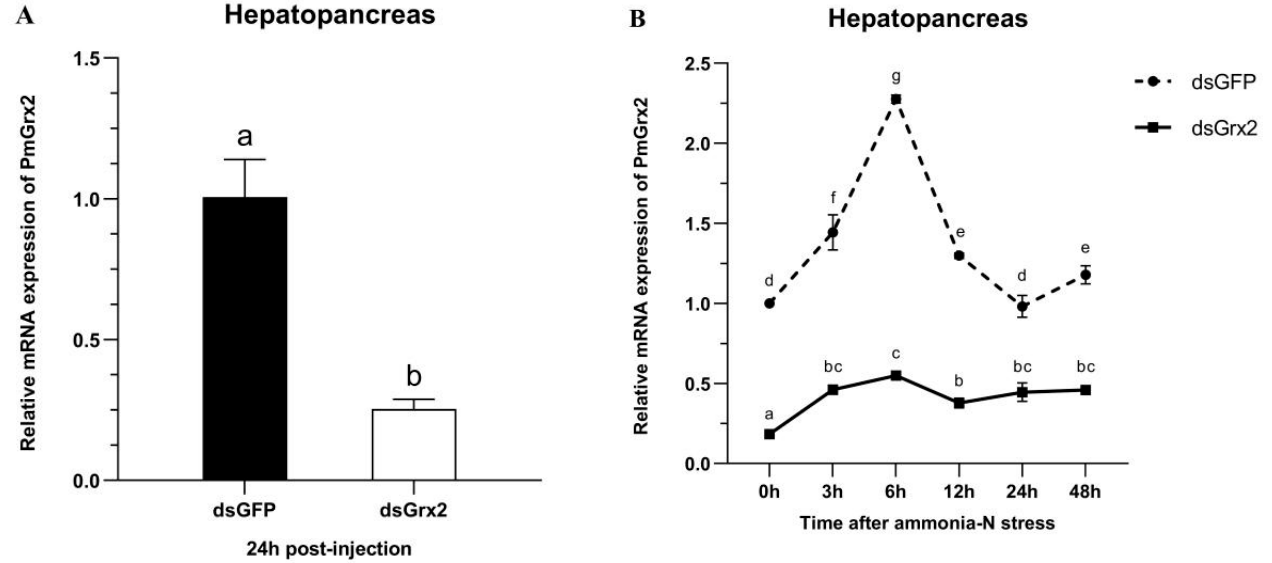
Figure 5. ( A ) mRNA expression levels of PmGrx2 in the hepatopancreas at 24 h after dsRNA injection. ( B ) Expression profile of PmGrx2 in the hepatopancreas of dsRNA-injected shrimps within 48 h under ammonia-N stress. The data are presented as mean ± SD (n = 3). Different letters show significant differences ( p < 0.05).